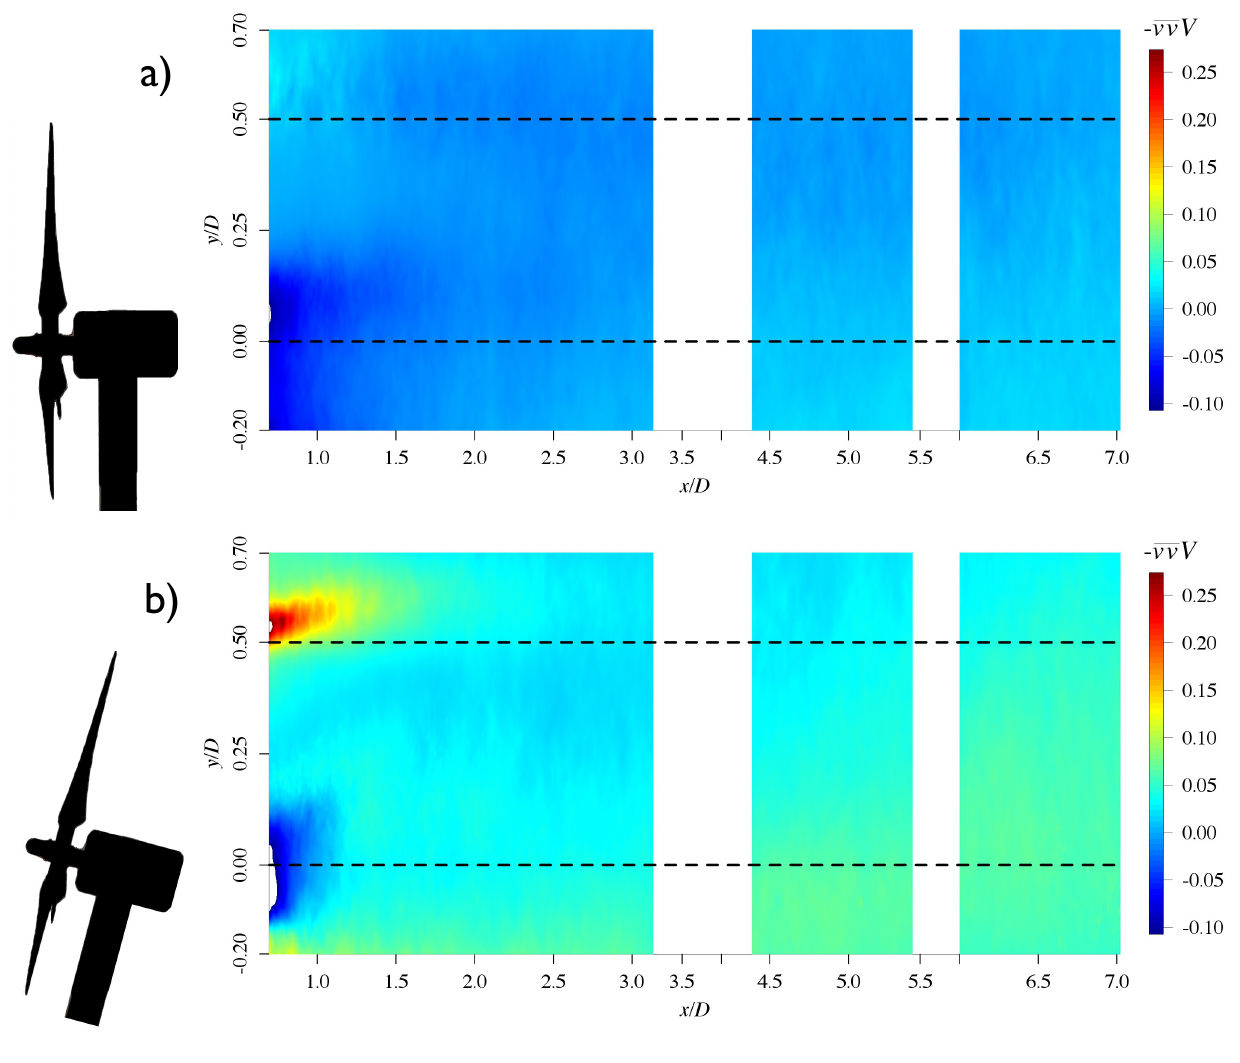
Figure 18. Turbulent kinetic flux in the wall normal direction component − vvV of the wake for fixed and floating